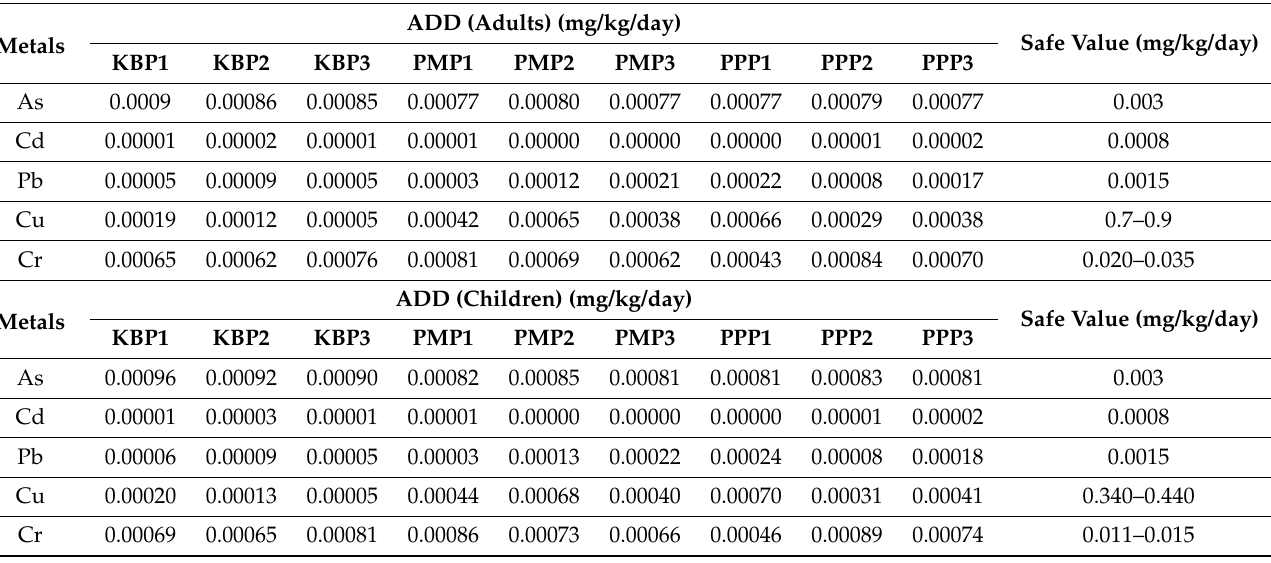
Table 8. Average daily dose (ADD) of heavy metals for adults and children via rice